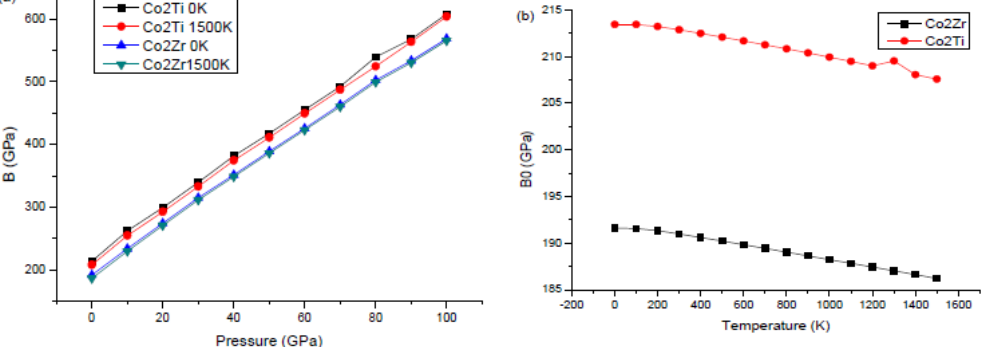
Figure 3. ( a ) The bulk modulus B versus pressure P at 0 and 1500 K, and ( b ) the bulk modulus B 0 versus temperature T from 0 up to 1500 K at P = 0 GPa.